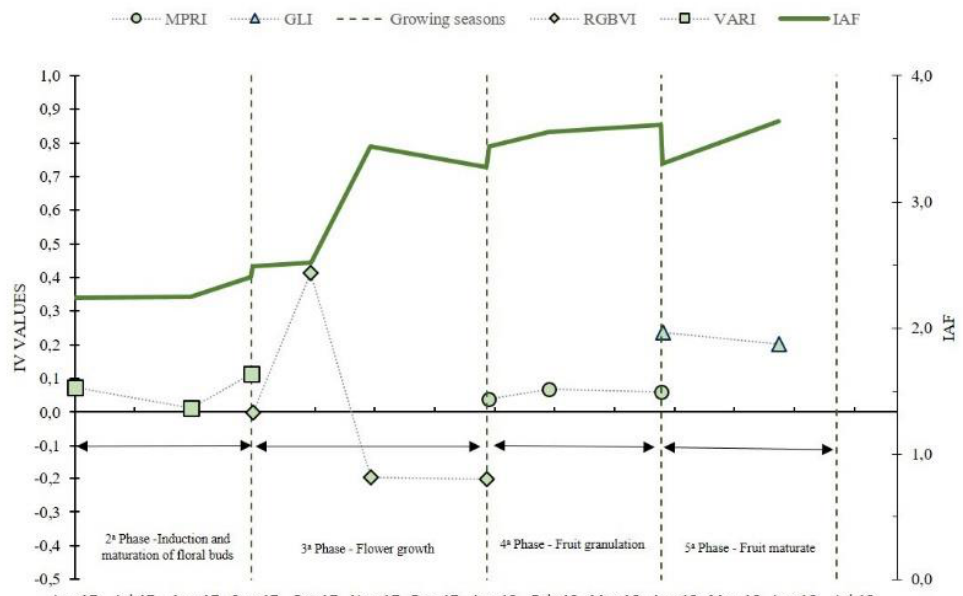
Figure 6. Behaviour of MPRI, GLI and LAI in the coffee production cycle.